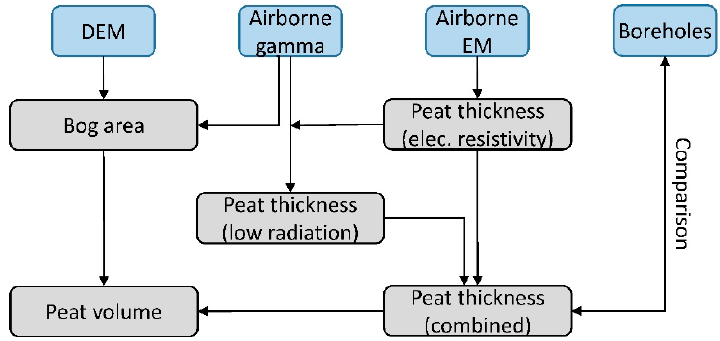
Figure 6. Workflow (blue colored: data, grey colored: objectives) for the estimation of peat volumes. HEM Analysis